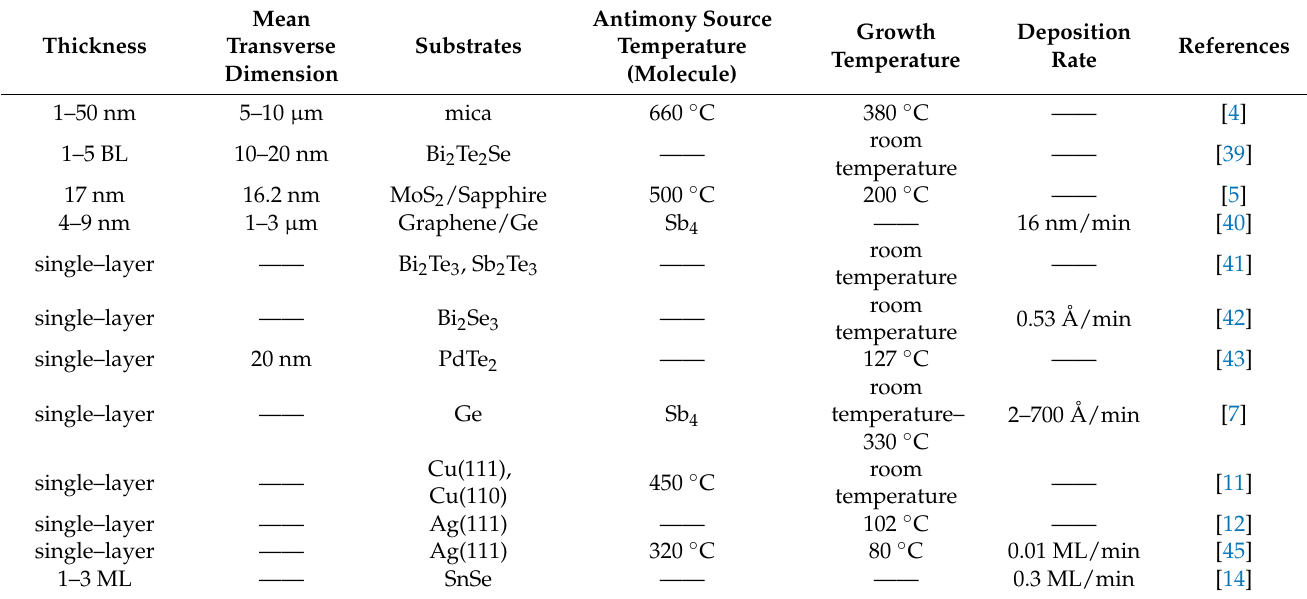
Table 1. Conditions of epitaxial preparation of